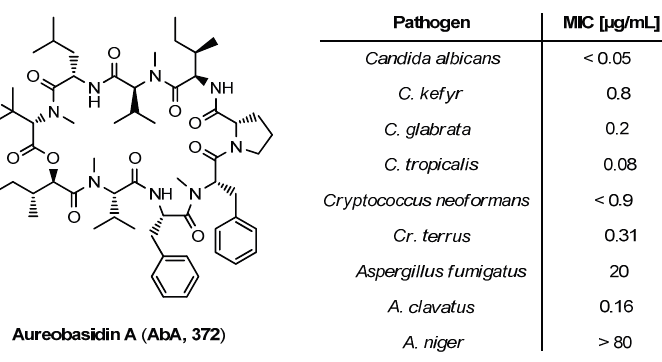
Figure 33. Structure and activity of aureobasidin A ( 372